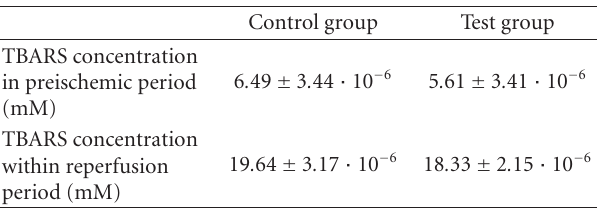
Table 2: TBARS levels in control (without glucagon) and test (in the presence of glucagon) groups taken during preischemic and reperfusion periods. Control group Test group TBARS concentration